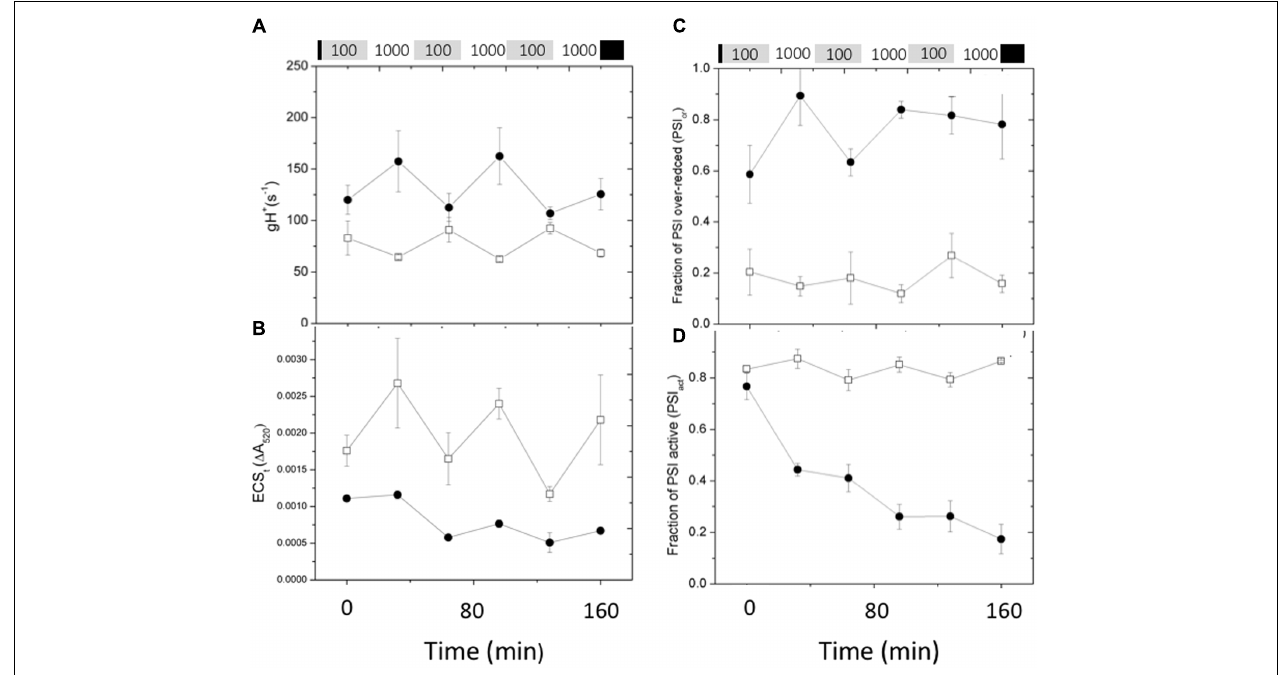
FIGURE 7 | Responses pmf and PSI to fluctuating illumination in Col-0 and cfq . Plants were treated as in Figure 6 . (A) Kinetics of the conductivity of the thylakoid membrane to protons ( g H + ); (B) ECSt, reflecting the light-induced thylakoid pmf . (C) Kinetics of the over-reduction state of PSI as estimated by the PSI or parameter; (D) kinetics of deactivation of PSI centers, as estimated by the PSI act parameter. Symbols indicate Col-0 (open squares) and cfq (closed circles).